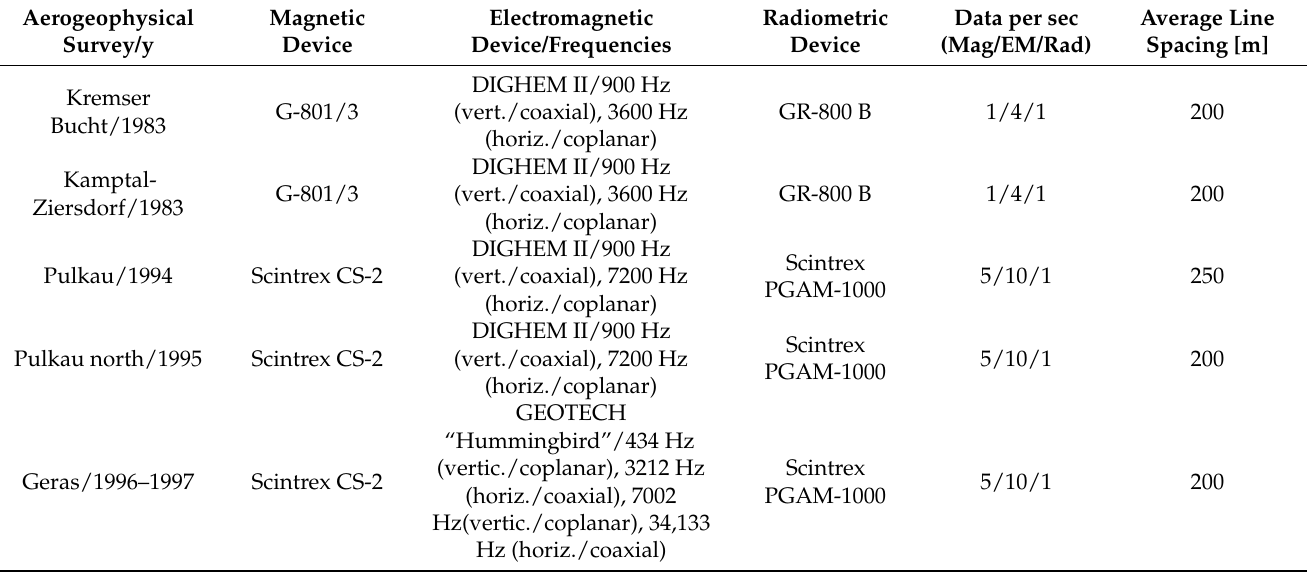
Table 1. Vintage data sets measured using different technical equipment and survey specification.